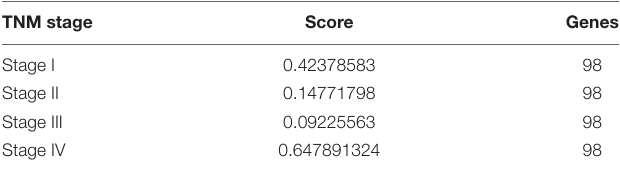
TABLE 3 | Dynamic network biomarker scores in different tumor stages in colon and rectal